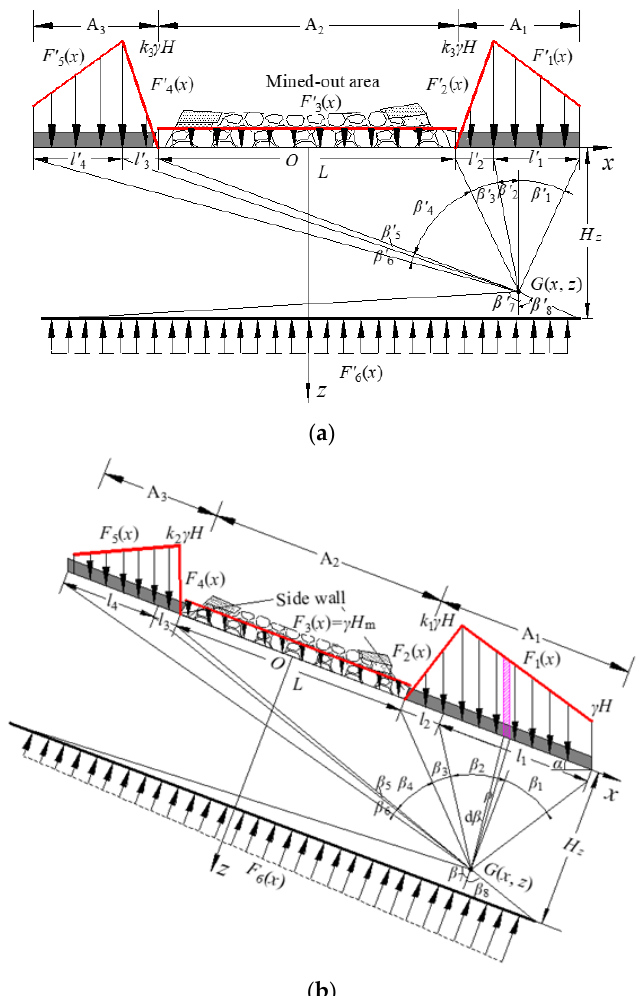
Figure 3. Hydraulic-mechanical (HM) models for seam floors. ( a ) A case with horizontal strata; ( b ) A case with inclined strata.